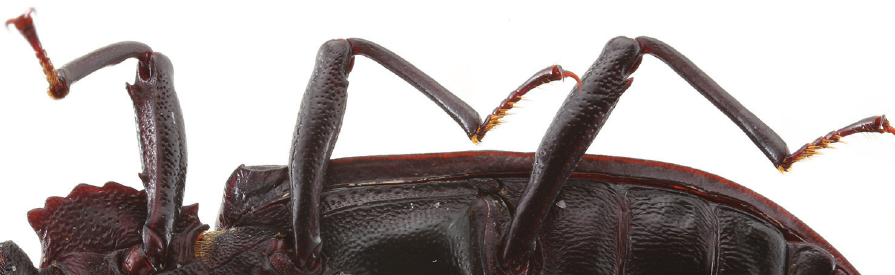
Figure 2. Femora of C. bispinosus , male, ventral